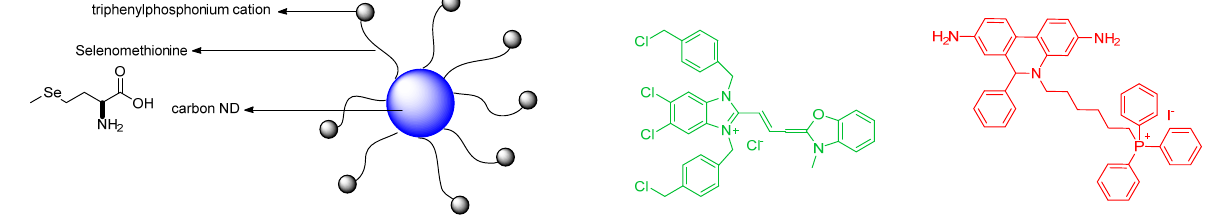
Figure 15. Structures of TPP–Se–CDs by Huang et al. and MitoTracker Green and MitoSox Red. In a paper from Zang et al. endoplasmic reticula were targeted for a chemosensing study. Reversible detection was studied. First, with a “turn–off” fluorescence with ClO − , then a reversible reduction of selenium with GSH was observed (Figure 16). The by–product of GSH is likely to be the oxidized form GS–SG or GS–E. The probe has a Ph–Se containing motif. The structure is the 1,8–naphthalimide framework. The name of the probe is ER – Se and the resulting green fluorescence was quantified. ER red tracker (ER–Tracker Red) was also used. This study also reported the use of HeLa cells [53].